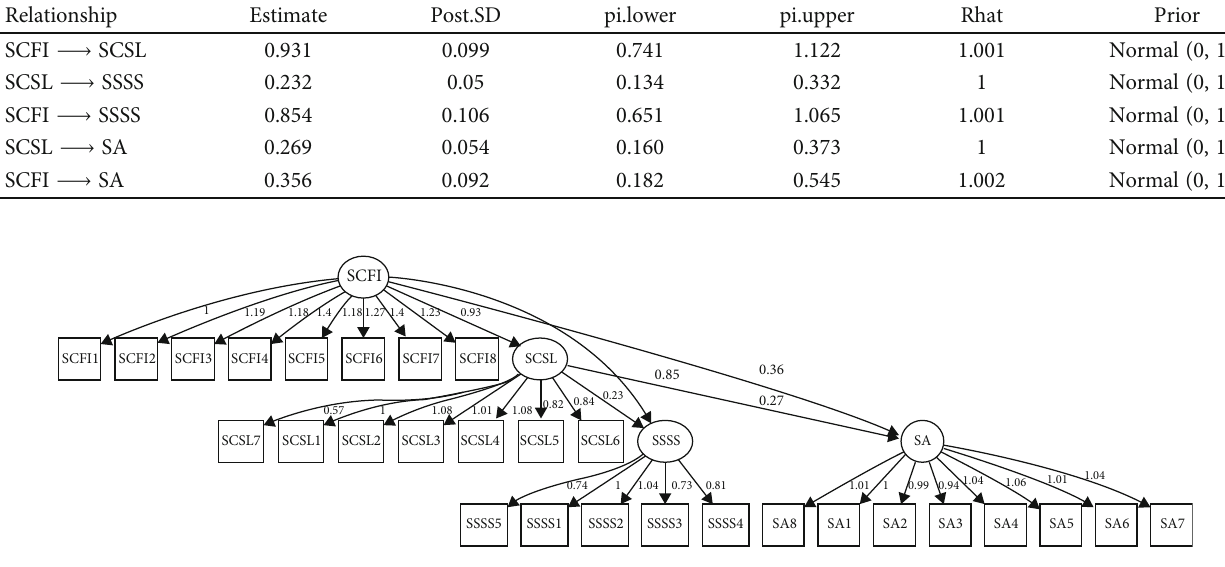
Figure 3: BSEM analysis of research